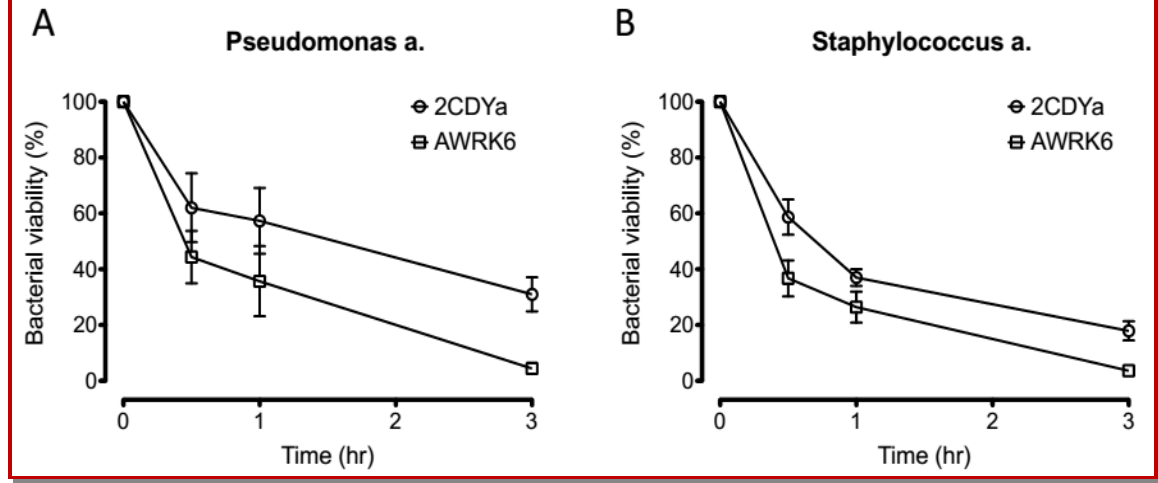
Figure 2: Growth inhibition of Pseudomonas a. and Staphylococcus a. by Dy2 and AWRK6 Bacterial suspension was diluted in each micro tube with 10 mM sodium phosphate buffer containing 0.1% TSB (pH 7.4). After incubating with either Dy2 or AWRK6 at the indicated concentrations at 37°C with shaking at 220 rpm for 3 hours, the number of viable cells was estimated by counting colonies. A. Inhibition of P. aeryginosa; B. Inhibition of S. aureus. Data are the means ± SEMs from six experiments